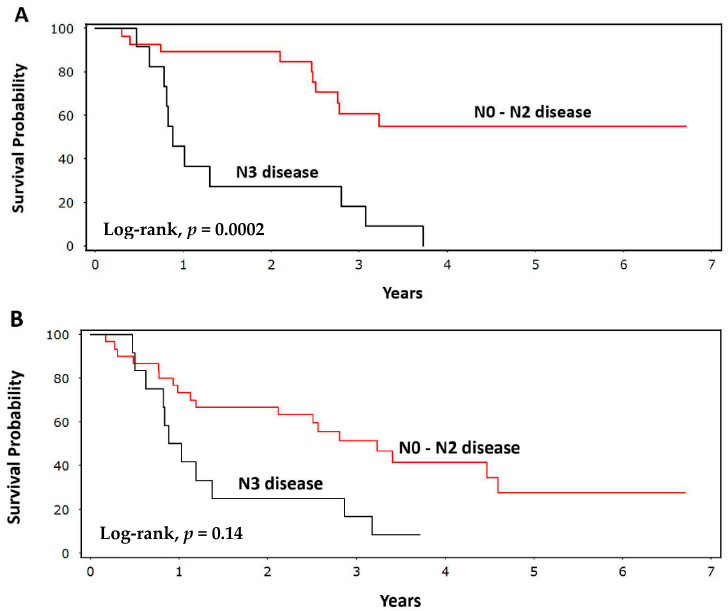
Figure 3. Kaplan–Meier plots showing ( A ) recurrence ‐ free survival ( p = 0.0002) and ( B ) overall survival ( p = 0.014) of patients with N0–N2 disease compared with patients having N3 disease.